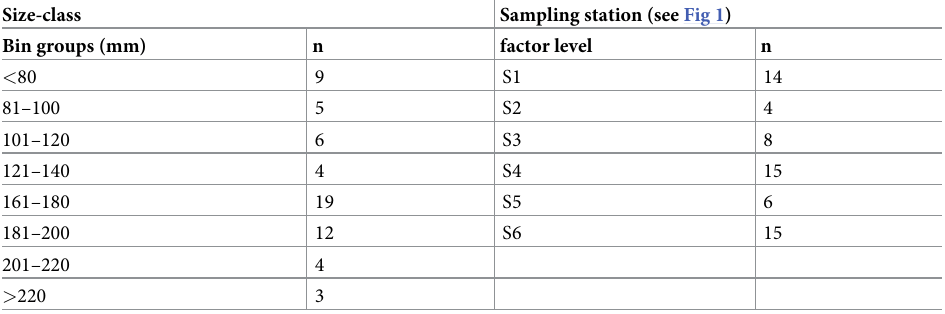
Table 2. Sample size for each factor level of size-class and sampling station for the permutational multivariate analysis of variance (PERMANOVA) and canonical analysis of principal coordinates